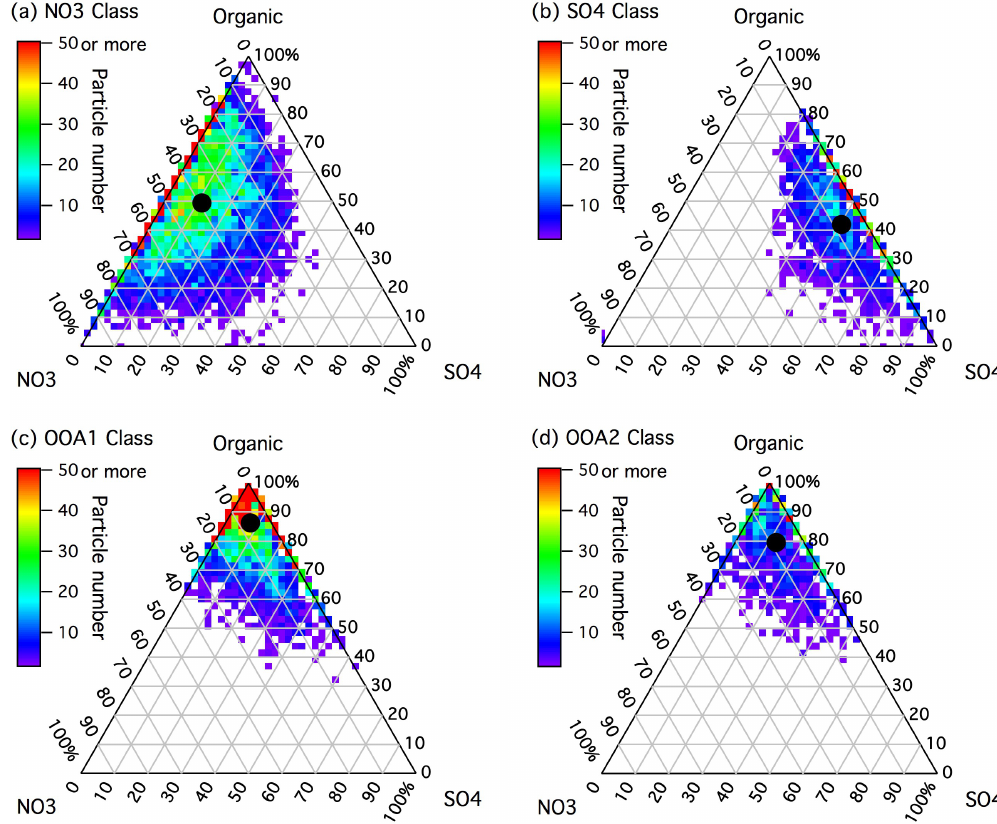
Figure 9. Ternary plot of nitrate, sulfate and organics mass fraction for those particles types identified by cluster analysis: (a) NO 3 , (b) SO 4 , (c) OOA1, and (d) OOA2. All these particle classes are the major contributors in the accumulation-mode particles. The black solid circles indicate the coordinates of average compositions of each particle